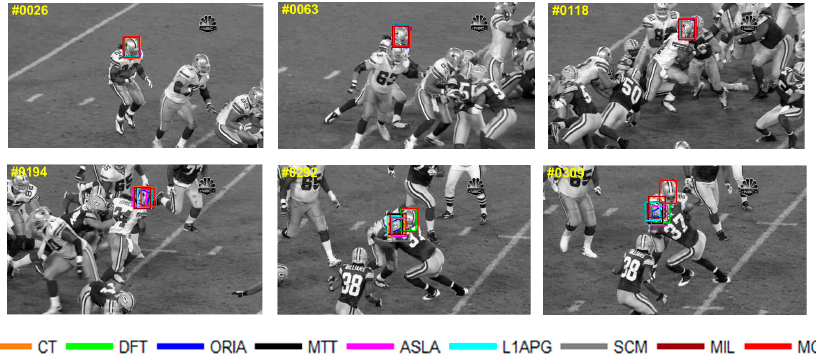
Figure 12. Tracking results on Football .